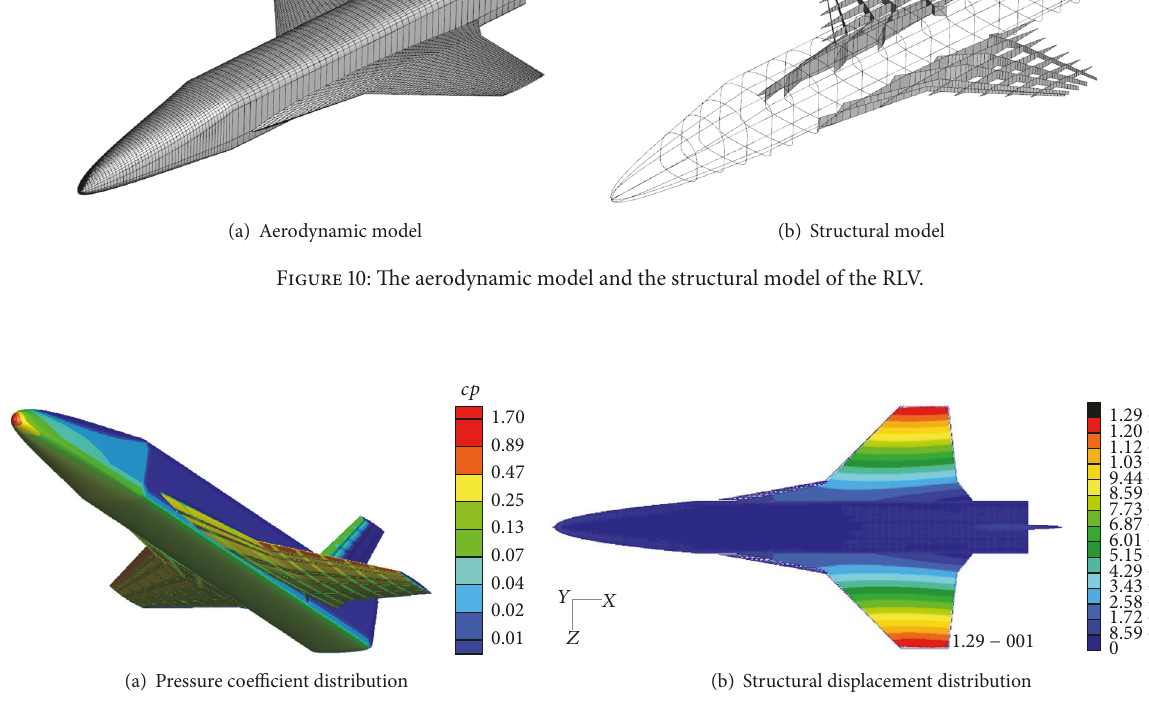
Figure 11: Pressure coefficient distribution and structural displacement distribution at the evaluation